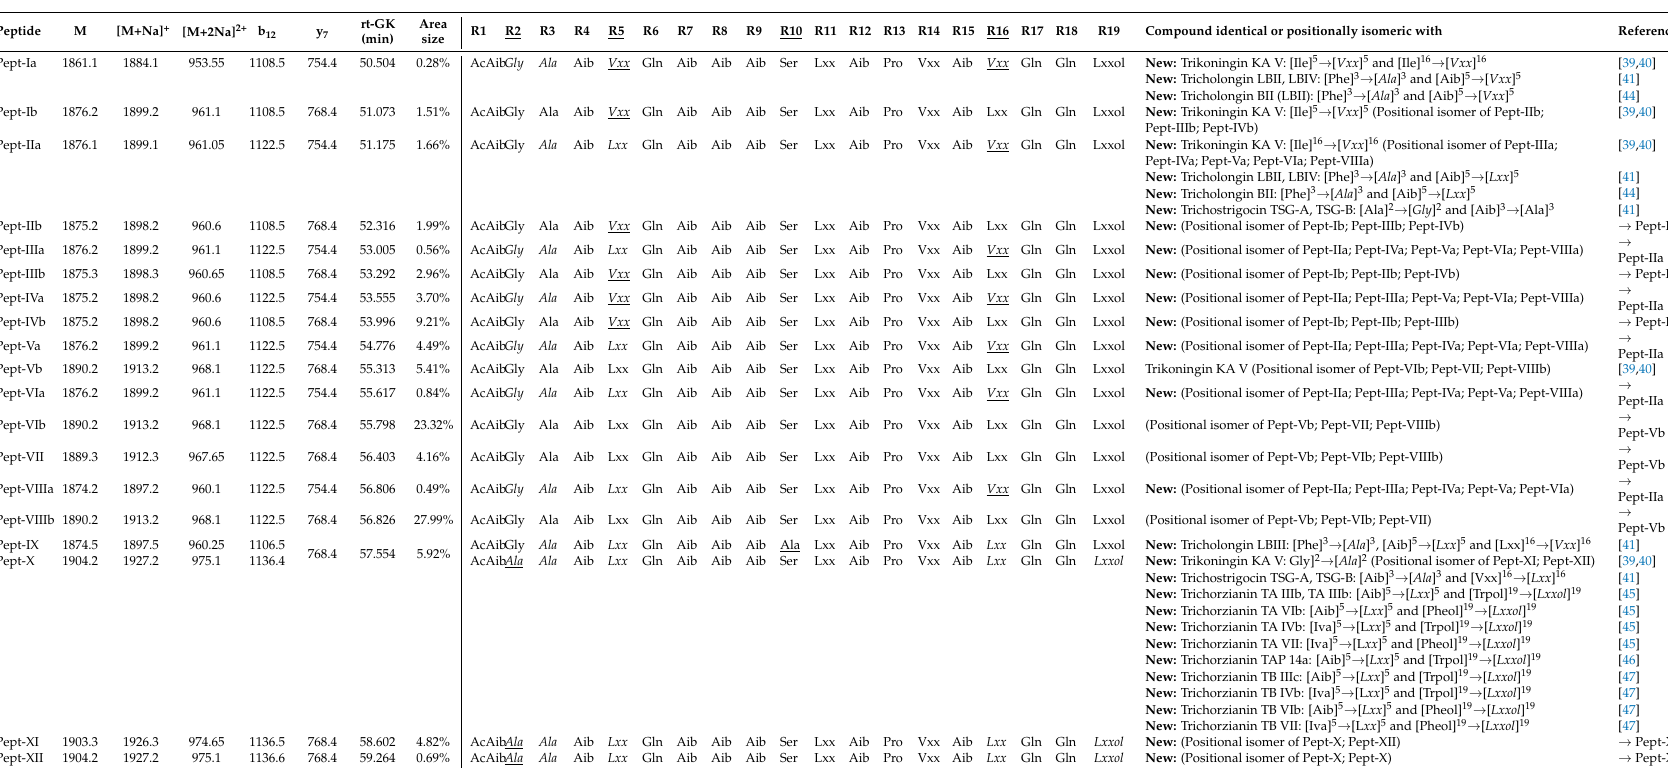
Table 1. Sequences of the newly identified peptaibol compounds produced by T. gamsii SZMC 1656 and their similarities to known peptaibols available in the “Peptaibiotics